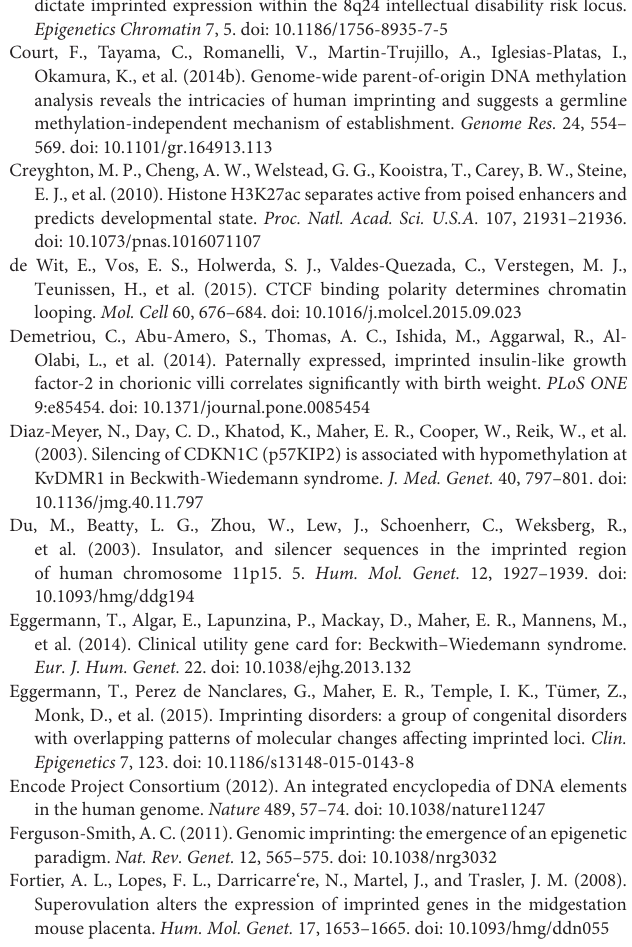
TABLE S1 | Oligonucleotide PCR primers used in this study. TABLE S2 | Summary of the experimental results that based our selection for internal control genes in placental tissue. MRPL19 , mitochondrial